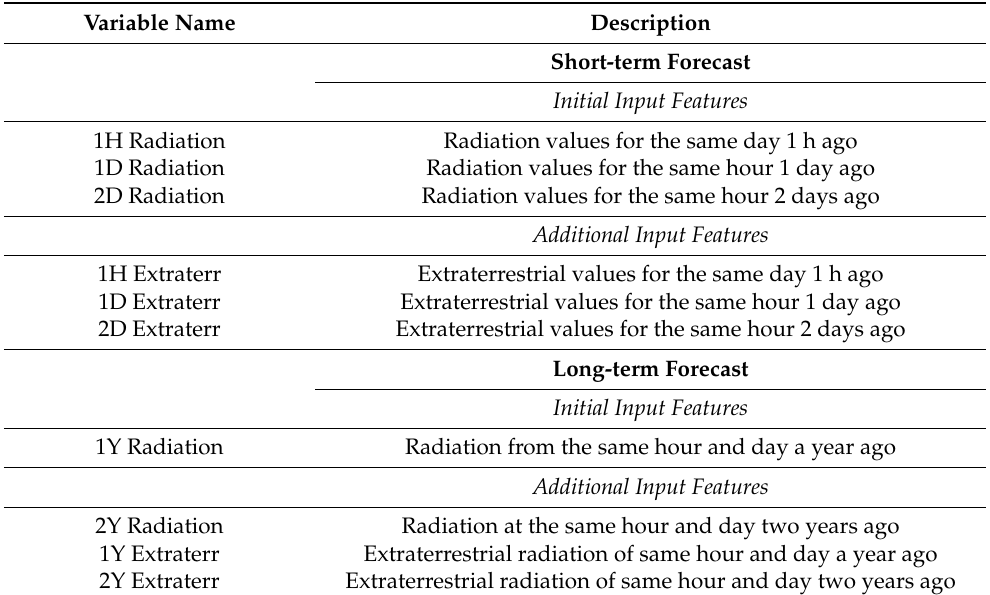
Table 2. Initial and additional features for SVM short- and long-term forecast.